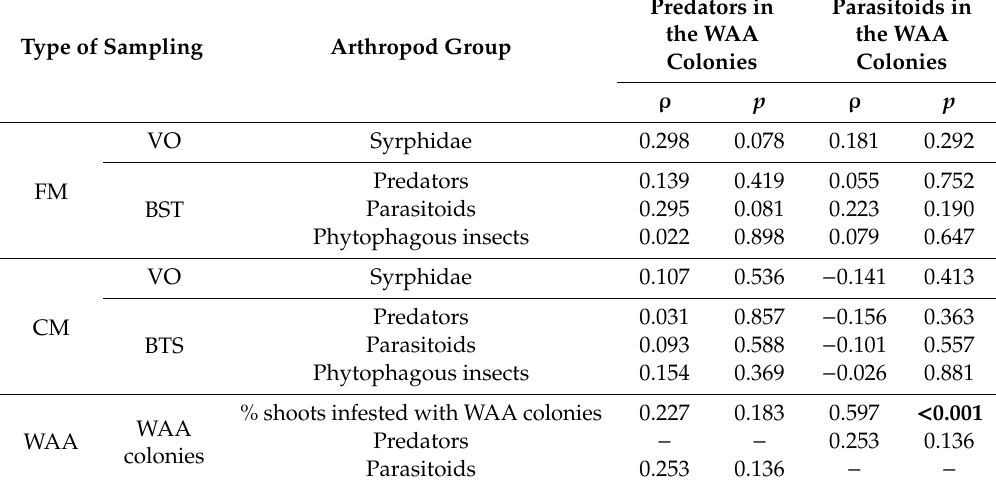
Table 4. Spearman correlation coe ffi cients ( ρ ) between the number of predators and parasitoids found in the WAA colonies and the number of arthropods found in visual observations (VO) and beating tray samplings (BTS) in the flower margin (FM) and control margin